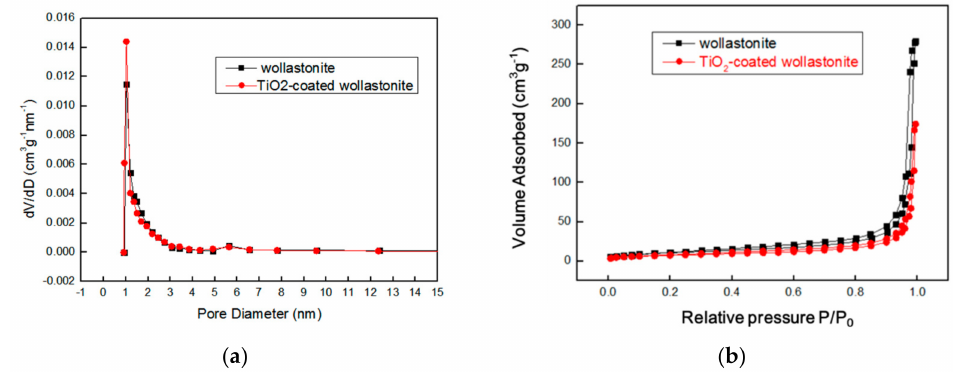
Figure 8. ( a ) Pore diameter distribution of wollastonite and TiO 2 -coated wollastonite (the final product); ( b ) the isotherm of N 2 adsorption-desorption on wollastonite and TiO 2 -coated wollastonite (the final